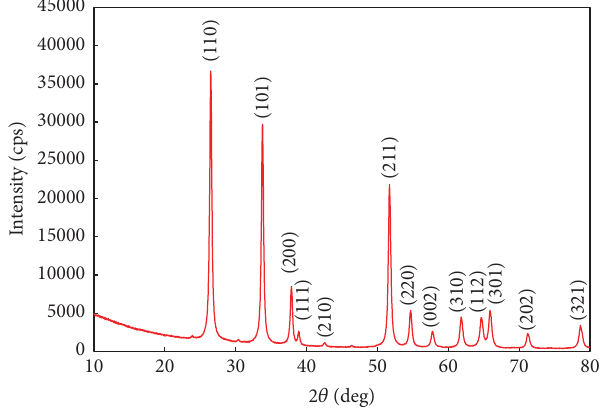
Figure 2: XRD pattern of FTO